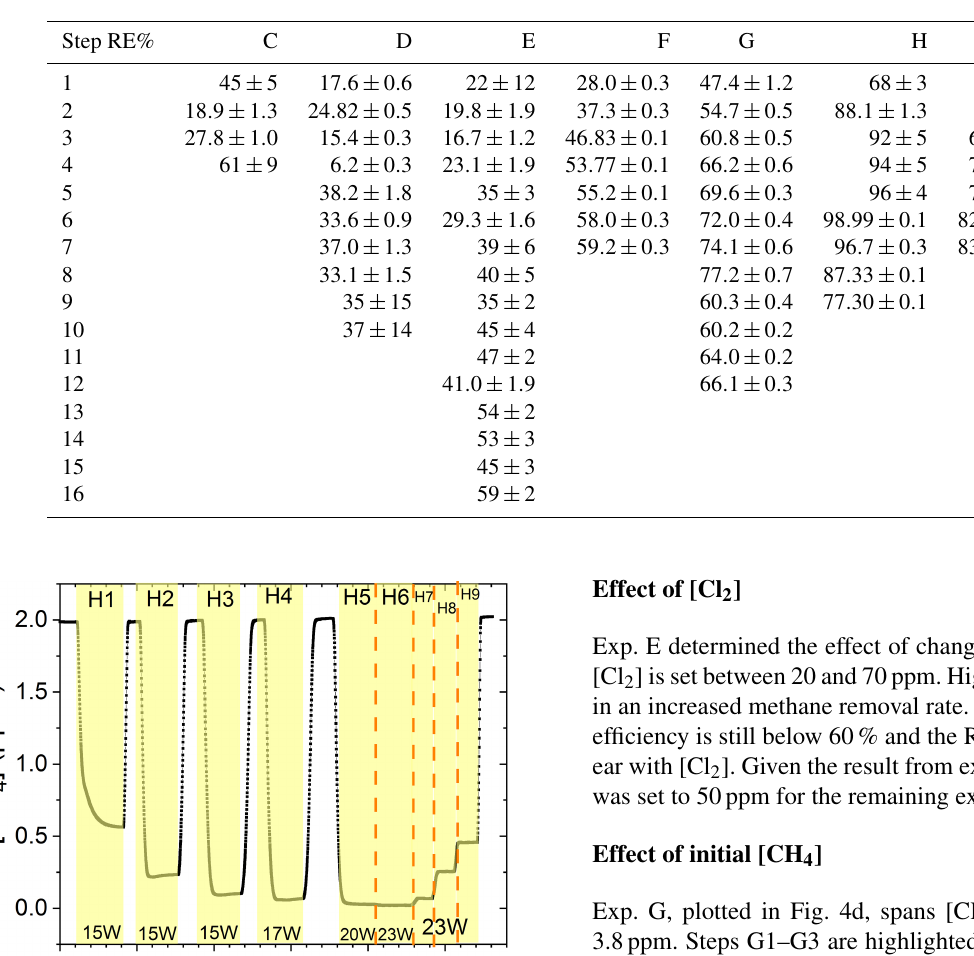
Table 3. Removal efficiencies (%) for experiments C–I.